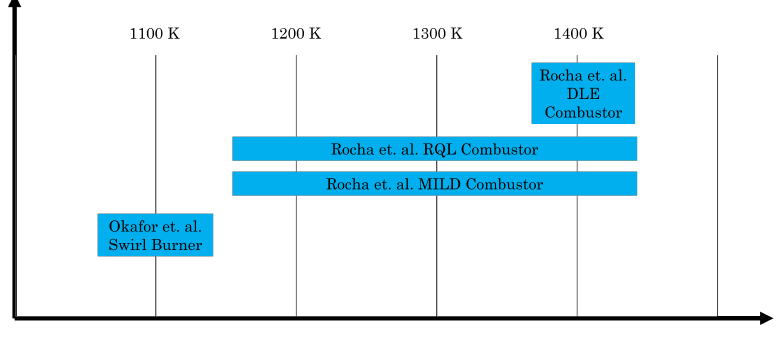
Figure 5. The combustor exhaust temperature ranges from various studies modelling the combustion of pure ammonia in a GT burner [53–55]. For the current study, 1400 K was ultimately selected as the combustor exhaust